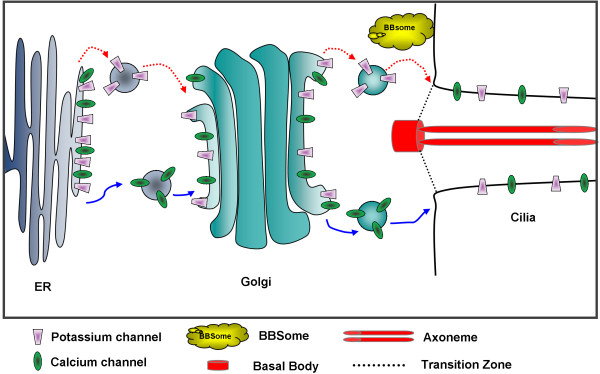
Cartoon of BBSome trafficking in Paramecium. Proteins are sorted from the endoplasmic reticulum (ER) to the Golgi and from the trans-Golgi network to the base of the cilia either in a BBSome-dependent pathway (red arrow with a dotted line) or a BBSome-independent pathway (blue arrow). The K+ channel (purple trapezoid) is trafficked to the cilia via the BBSome-dependent pathway while the Cav channel (green oval) is sorted via the BBSome-independent pathway. Structural proteins (not shown) traffic through cargo interactions with the BBSome to the cilia.